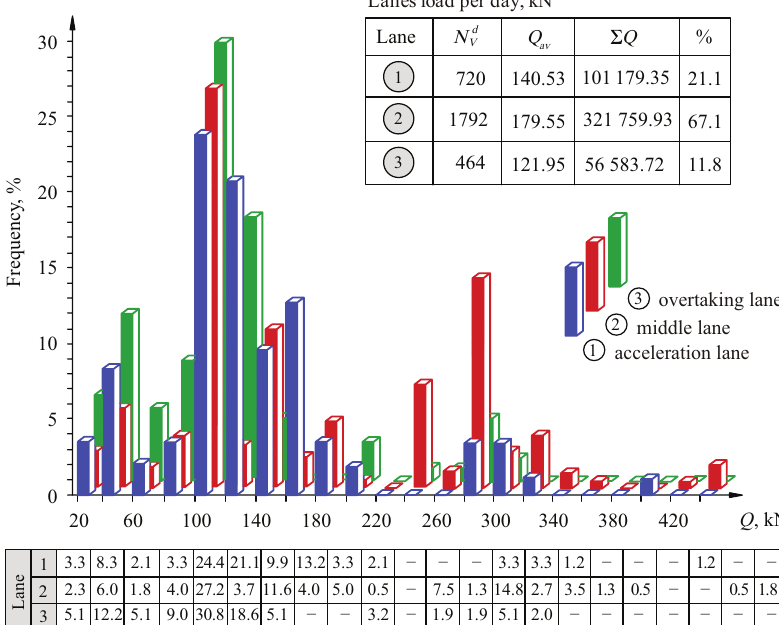
Figure 4. Histograms of total weights of vehicles for individual traffic